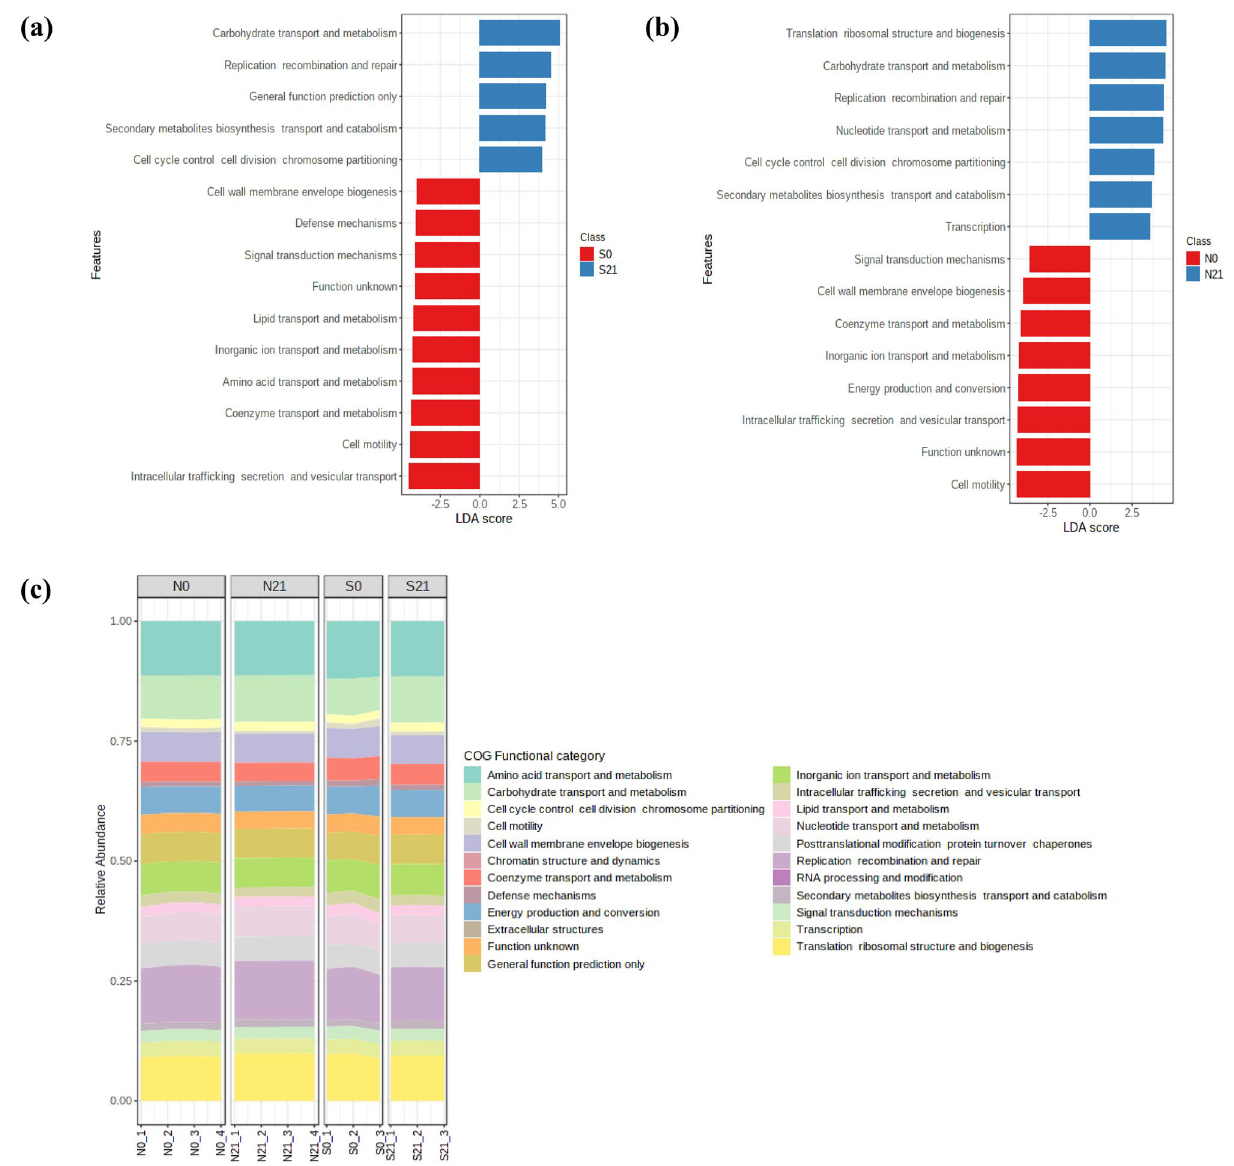
Figure 12. Stacked bar chart and graphic of linear discriminant analysis (LDA) effect size (LEfSe) of COG functional categories across samples, ( a ) sweet corn and ( b ) Napier ( c ) relative abundance of COG functional categories across samples (S0, Fresh sweet corn; S21, Sweet corn silage; N0, Fresh Napier; N21, Napier